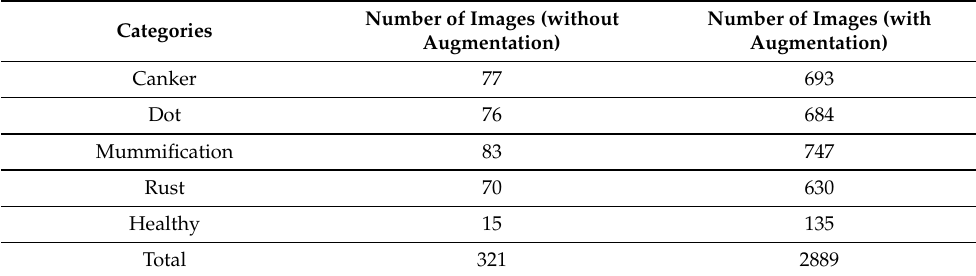
Table 6. Dataset description with and without augmentation.